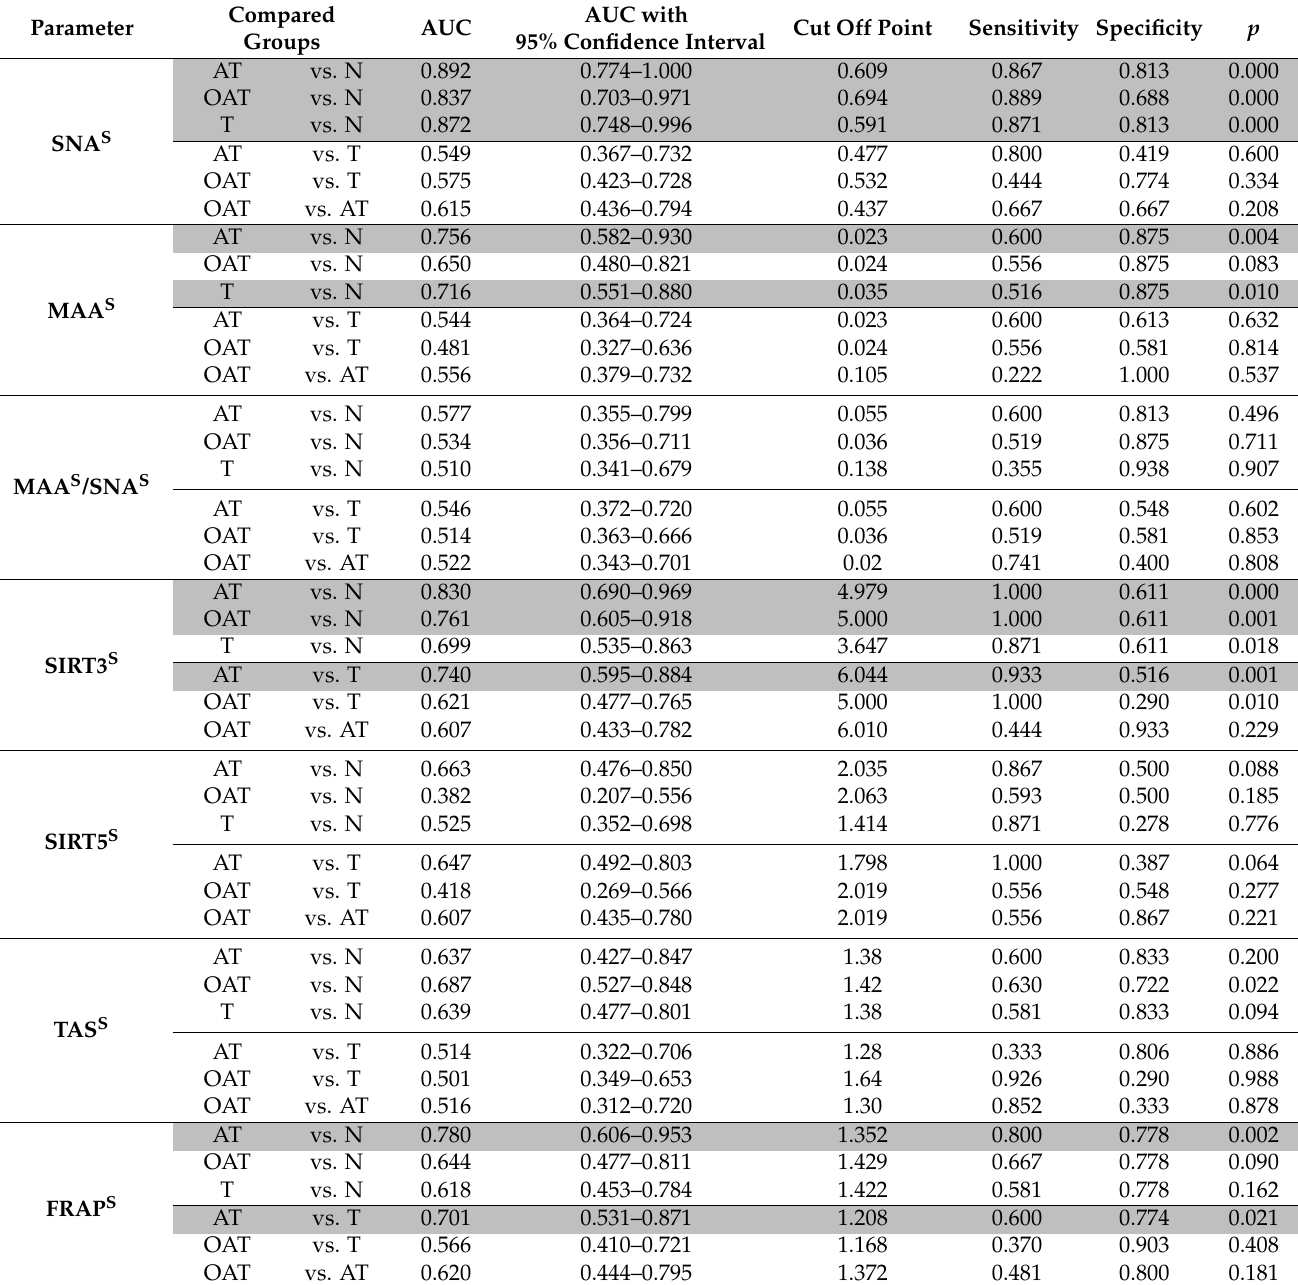
Table 3. Summary of receiver operating characteristic (ROC) curves for serum